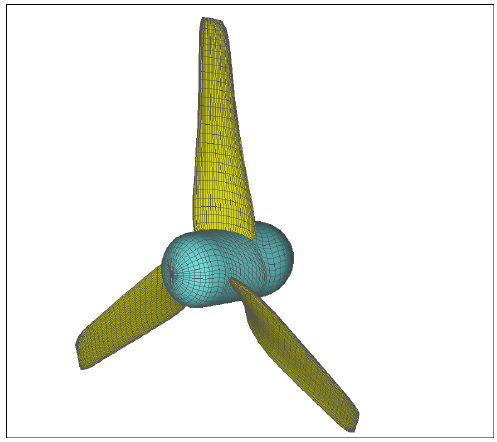
Fig. 4. Example of computational grid for turbine hydrodynamics predictions by BIEM-VFC